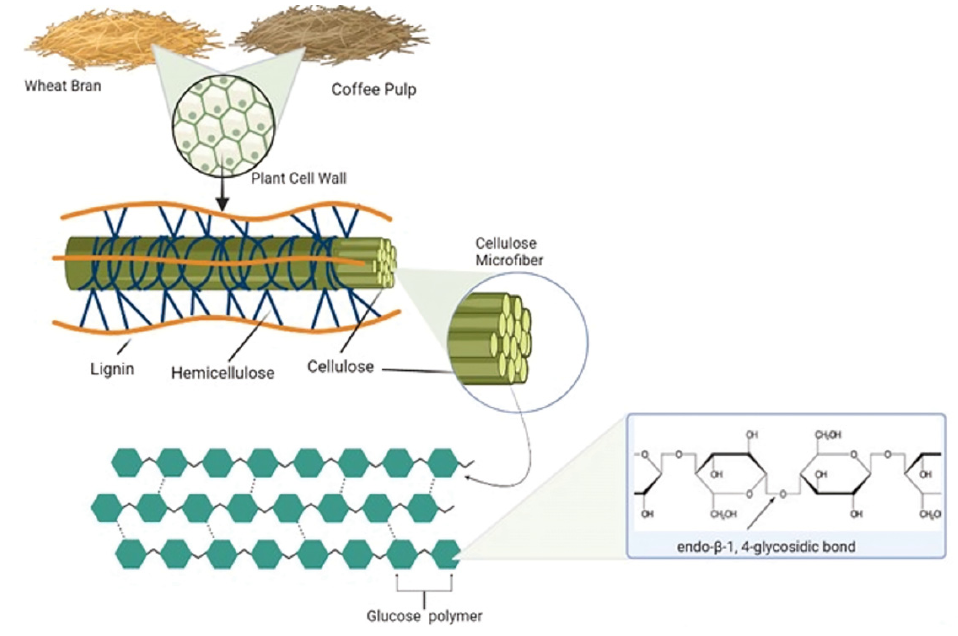
Figure 1. A brief diagrammatic structure and chemical composition of lignocellulose biomass. Wheat bran and coffee pulp cell walls contain a thick layer made of cellulose, hemicellulose, and lignin. This is an illustration of the β -(1,4)-glycosidic bond, which Carboxymethyl Cellulase (CMCase) would act